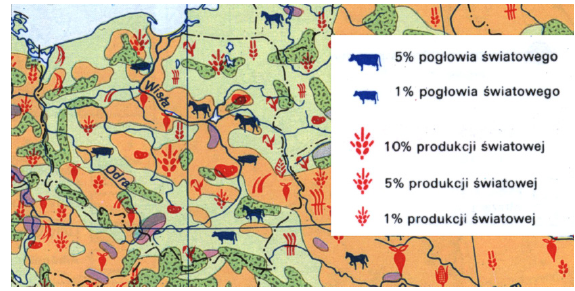
Fig. 10. Areal “quantitative signature symbols” used to show crop and animal